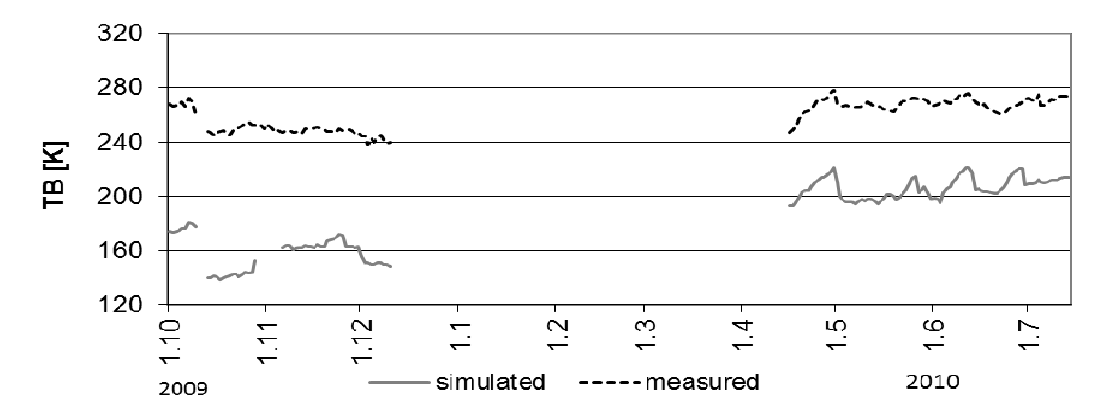
Figure 9. Comparison between simulated and measured TB on the basis of using the standard parameters according to literature—horizontal